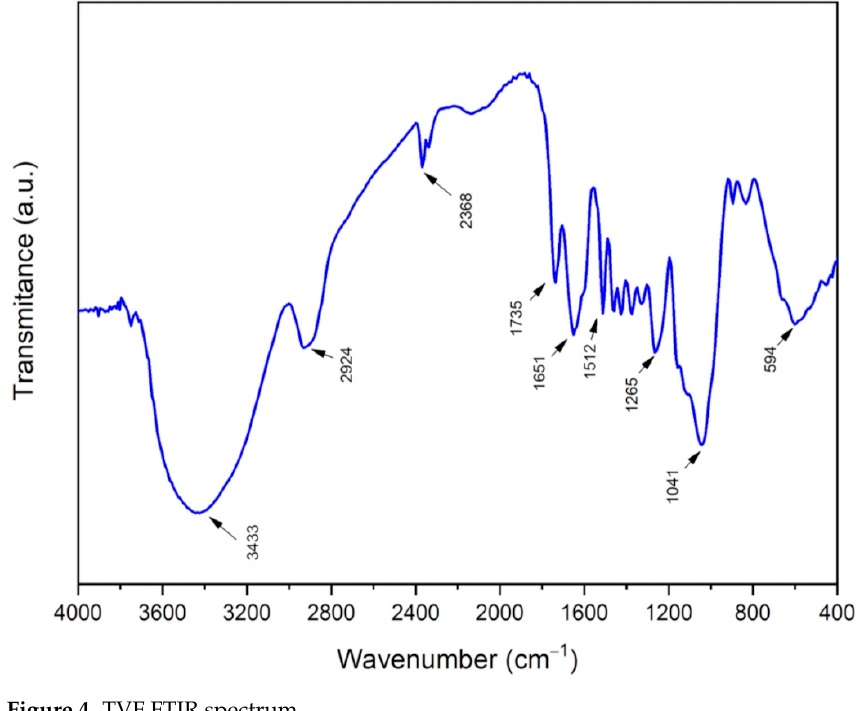
Figure 4. TVF FTIR spectrum.